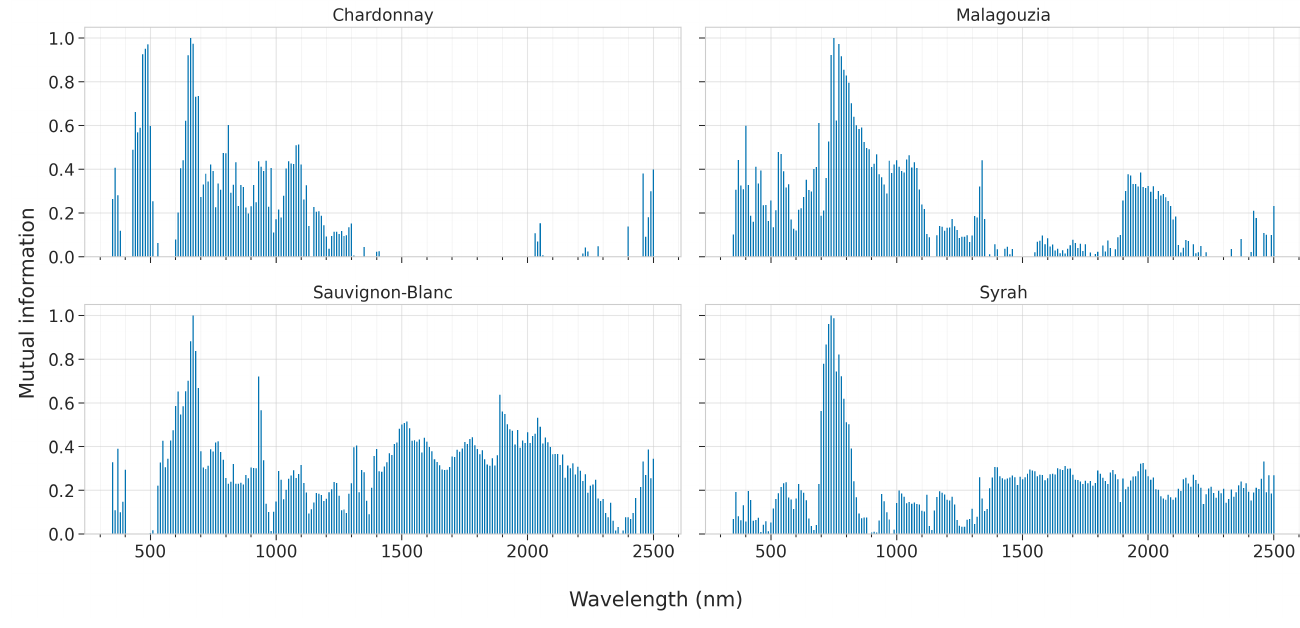
Figure 11. Mutual information-based feature ranking across the four grape varieties of the reflectance spectra; the higher the bar, the more informative the feature about the °Brix